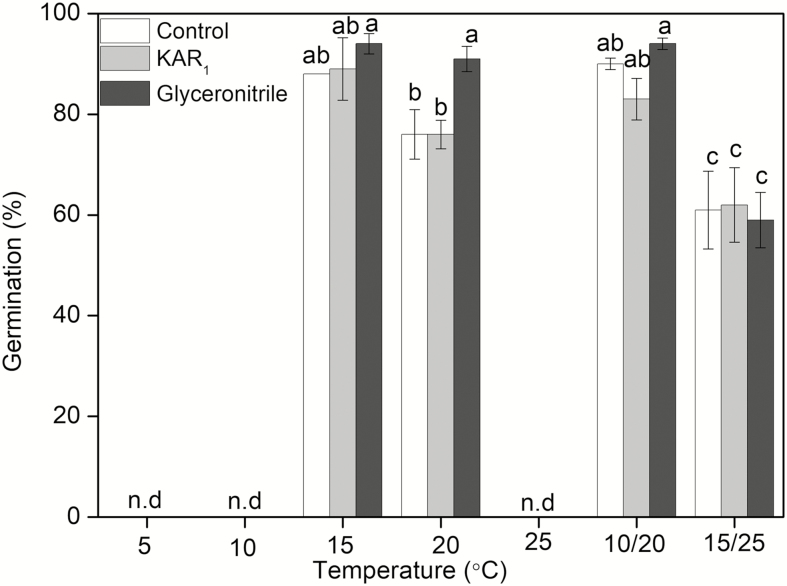
Germination (mean % ± SE) of after-ripened Anigozanthos flavidus seeds incubated at 5, 10, 15, 20, 25, 20/10 and 25/15 °C in a 12/12 h light/dark regime for 28 days on water (control), KAR1 or glyceronitrile. Different letters indicate significant differences (P < 0.05) between germination after 28 days across all treatments at different incubation temperatures. ‘n.d.’ means no germination was recorded at these temperatures.